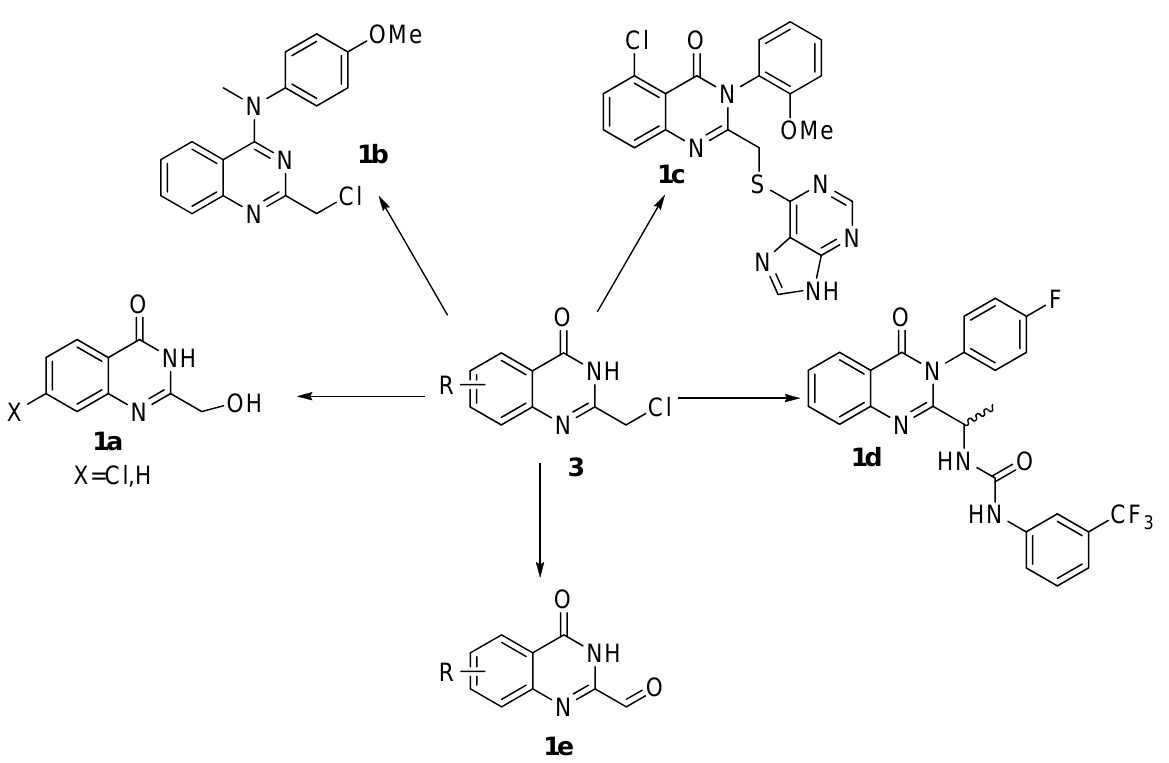
Figure 1. The versatile conversion of 2-chloromethyl-4(3 H )-quinazolinones 3 .